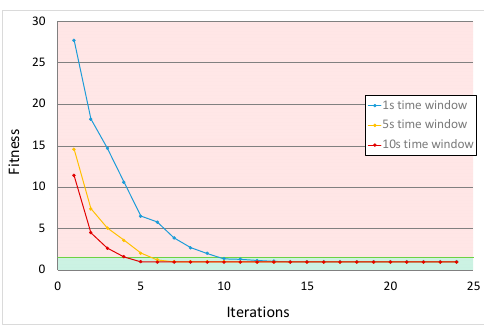
Figure 10. Evolution of the mean value of the fitness of the best solution found by the DE algorithm for the case of two intermediate timing points.